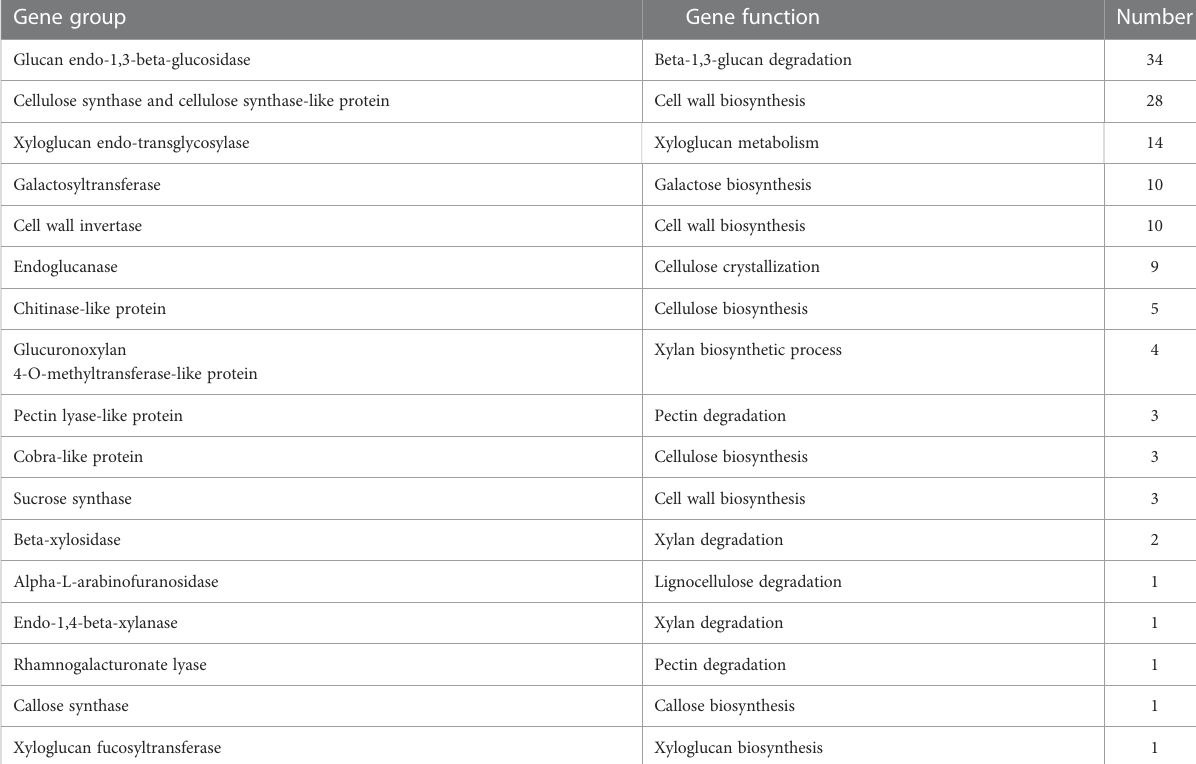
TABLE 7 Classi fi cation of cell wall related genes differentiallyexpressed(|log2FoldChange|> 1 and padj< 0.05) under 24 h and 48 h freezingtreatment. Gene group Glucan endo-1,3-beta-glucosidase Cellulose synthase and cellulose synthase-like protein